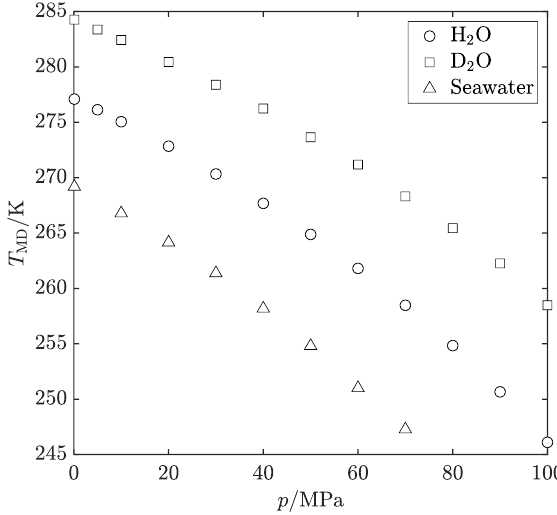
Fig. 9. Comparison of temperatures of maximum density as a function of pressure for all three investigated liquids. Points corresponding to seawater above 40 MPa were calculated from relative densities extrapolated to lower